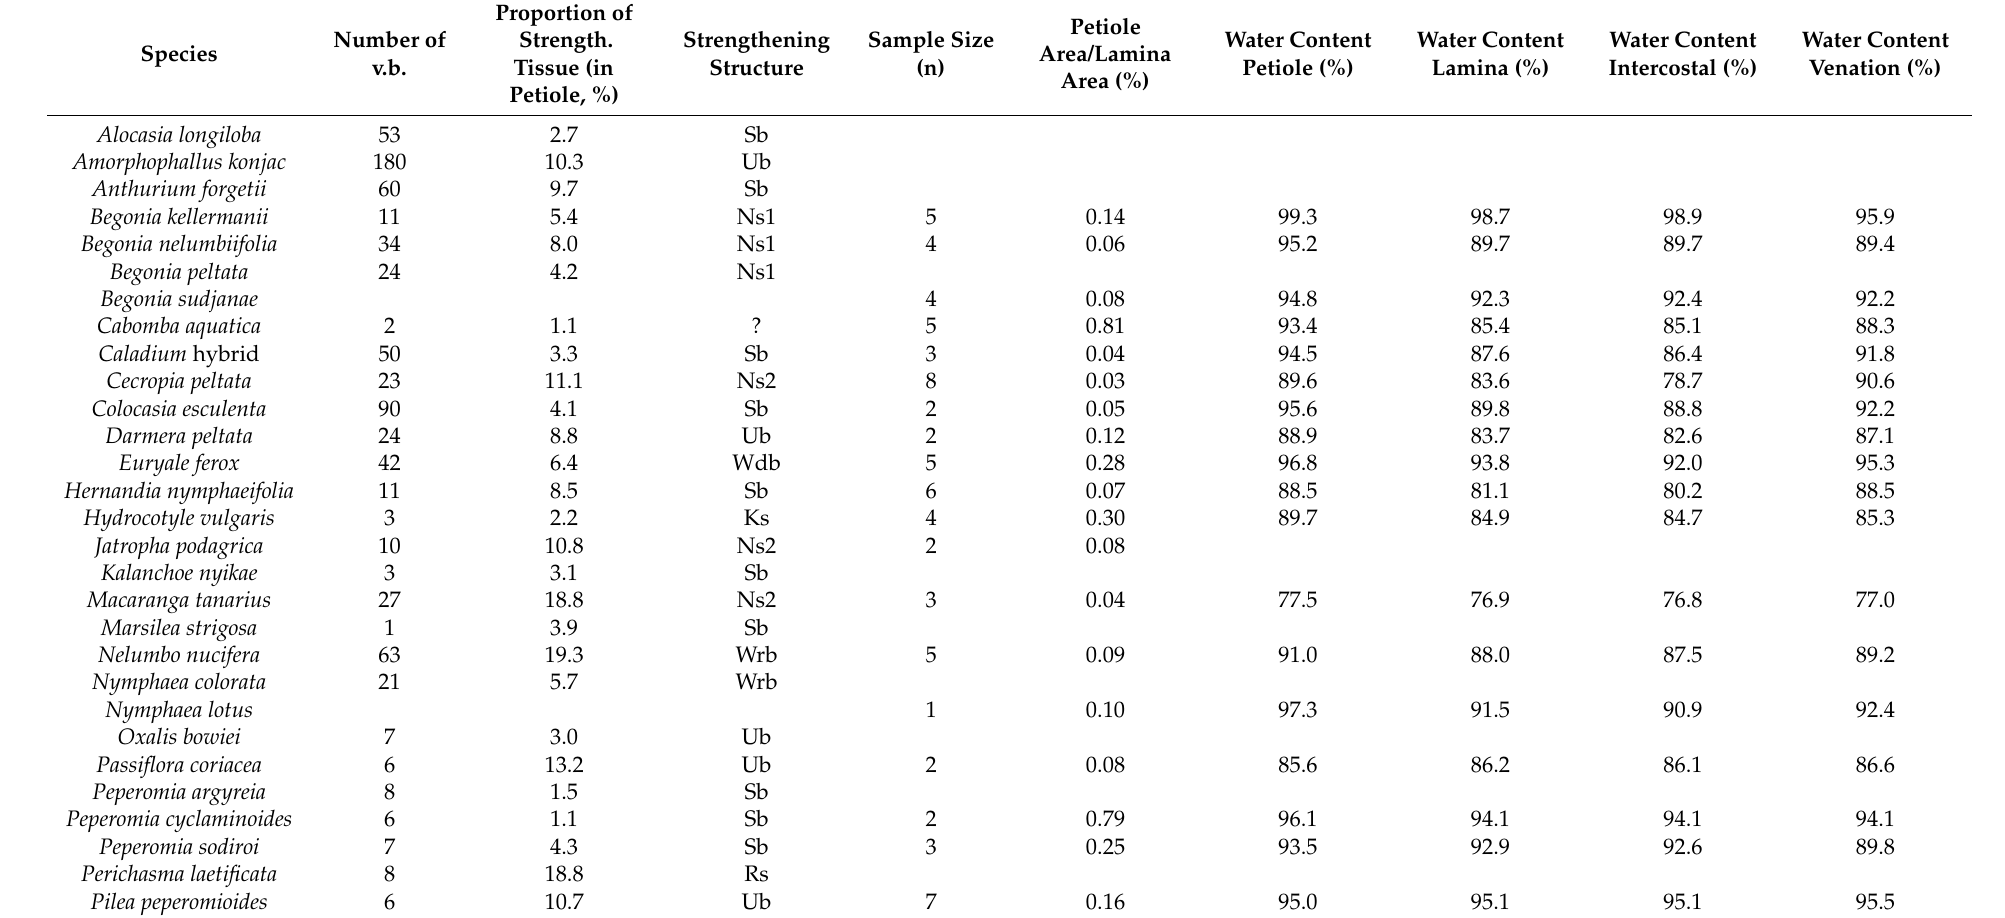
Table 2. Leaf characteristics of peltate plant species. The number of petiole vascular bundles (v.b.), ratio of strengthening tissue (only lignified tissue) in % in petiole cross section, strengthening structure, the ratio of petiole area to lamina area in % and water content in % of petiole, lamina in total, intercostal areas and venation of 41 peltate species were analysed